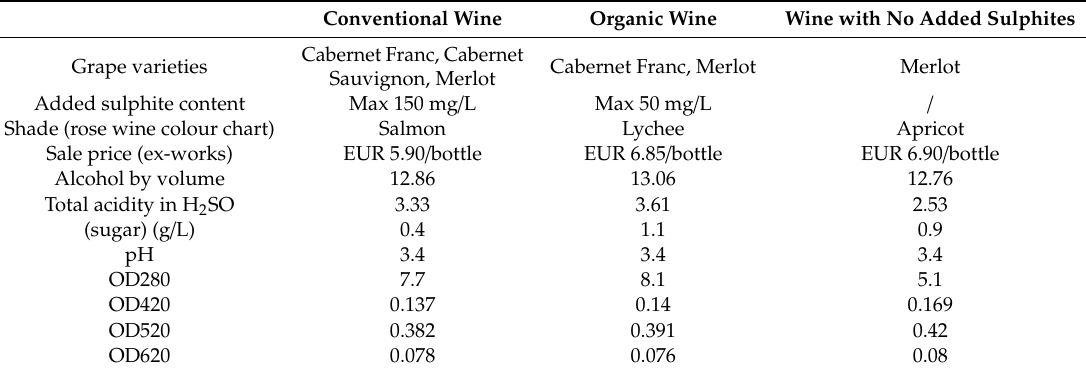
Table 2. Technical and analytical characteristics (FOSS ® analysis) of wines